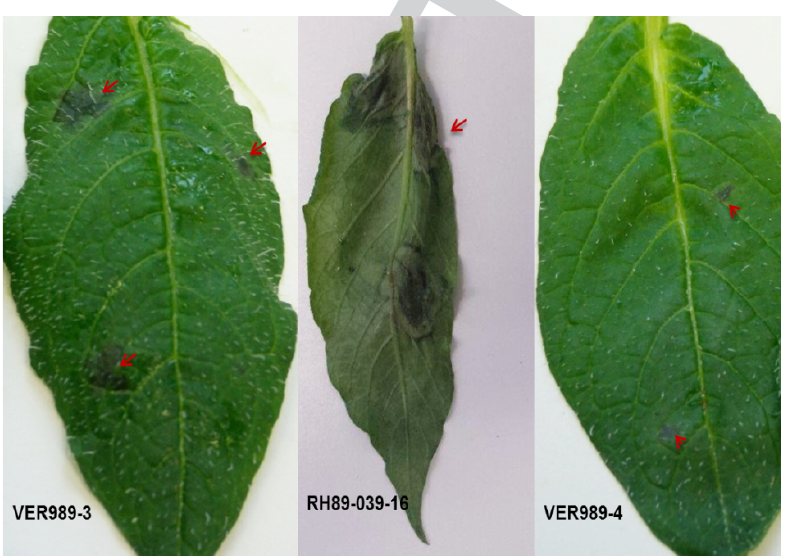
Figure 8. Lesion size from P. infestans isolate Katshaar on wild S. verrucosum genotype, RH89-039-16 was the control and two S. verrucosum (left & right) genotypes had strong cell